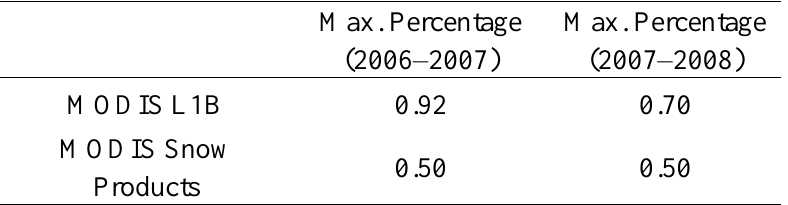
Table 1. Statistical results of snow covered percentages during two